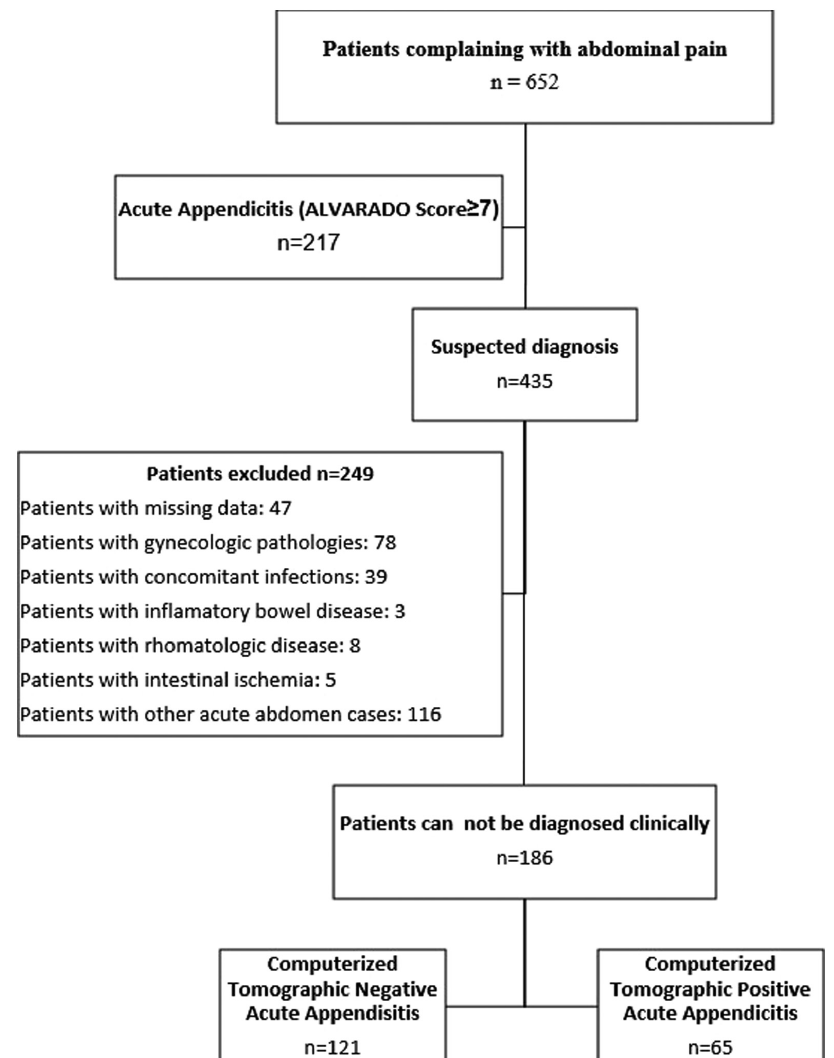
Figure 1. Flowchart of the study